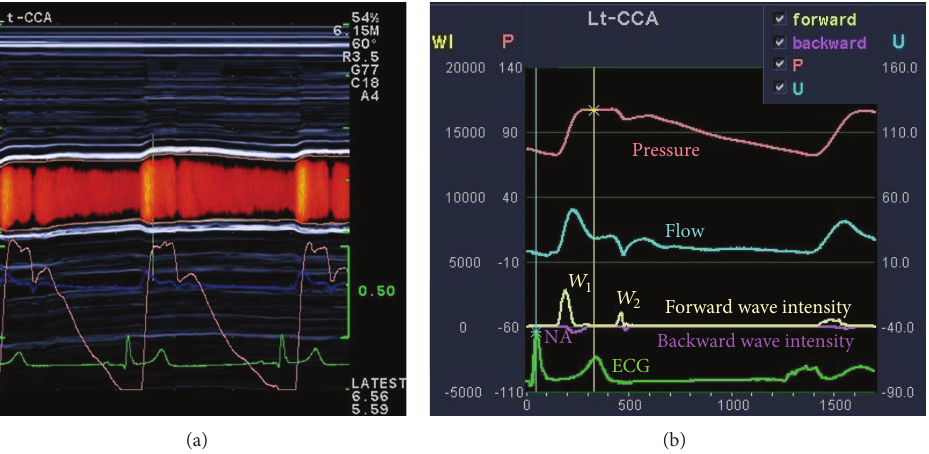
Figure 1: (a) Simultaneous measurement of CCA diameter changes (pink lines) creating the distension waveforms (analogous to a pressure waveform) and CCA blood flow velocity waveforms (dark blue) from echo tracking and color Doppler. (b) Representative view of results obtained from WIA. From top to bottom: distension (pressure) waveform, flow velocity waveform, wave intensity analysis ( 𝑊 1 , 𝑊 2 , and NA), and